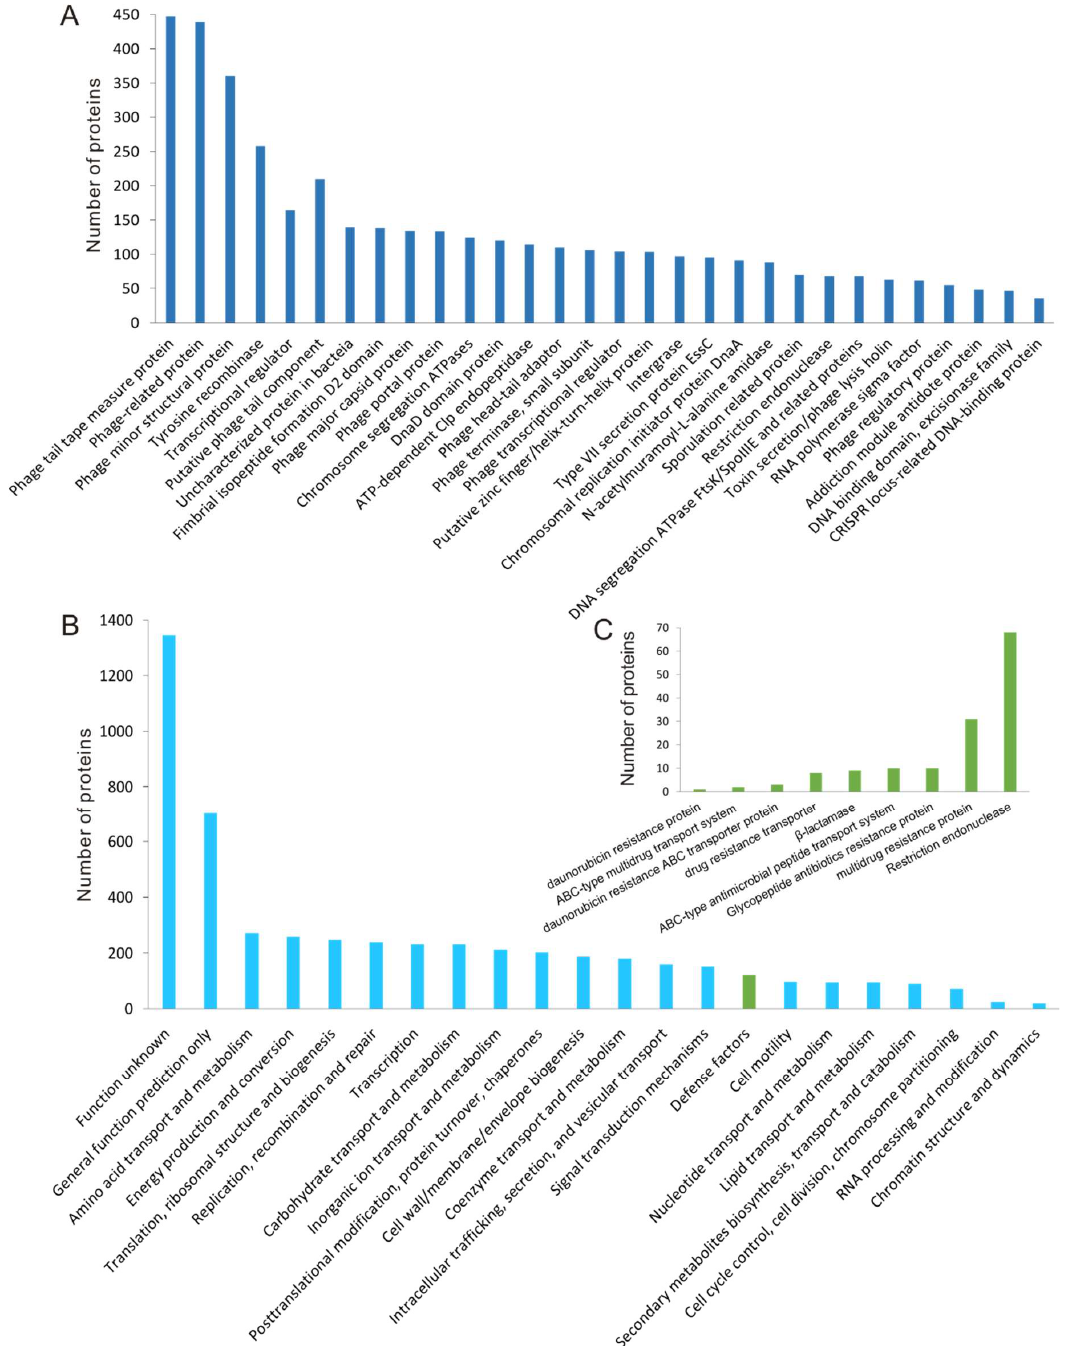
Figure 4. Functional classification of proteins encoded by prophage regions in Bt genomes. ( A ) The proteins related to phage lifecycles were encoded by 135 putative complete prophage genomes. Only proteins with more than 10 homologs of the same function were shown. ( B ) COG classification of proteins encoded by putative complete Bt prophages. ( C ) Functional classification of the proteins that were predicted to take part in the bacterial resistance to antibiotics and exogenous DNA and their corresponding transporter proteins.